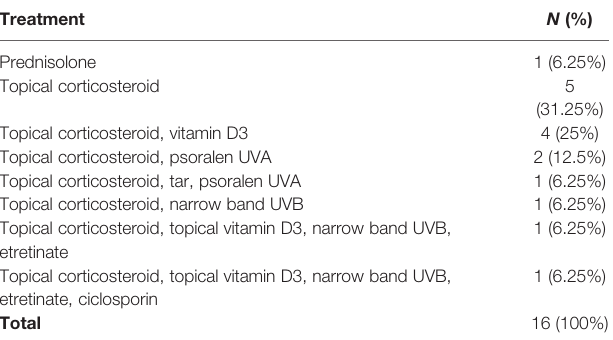
TABLE 5 | Therapy strategies for psoriasis before blister formation.